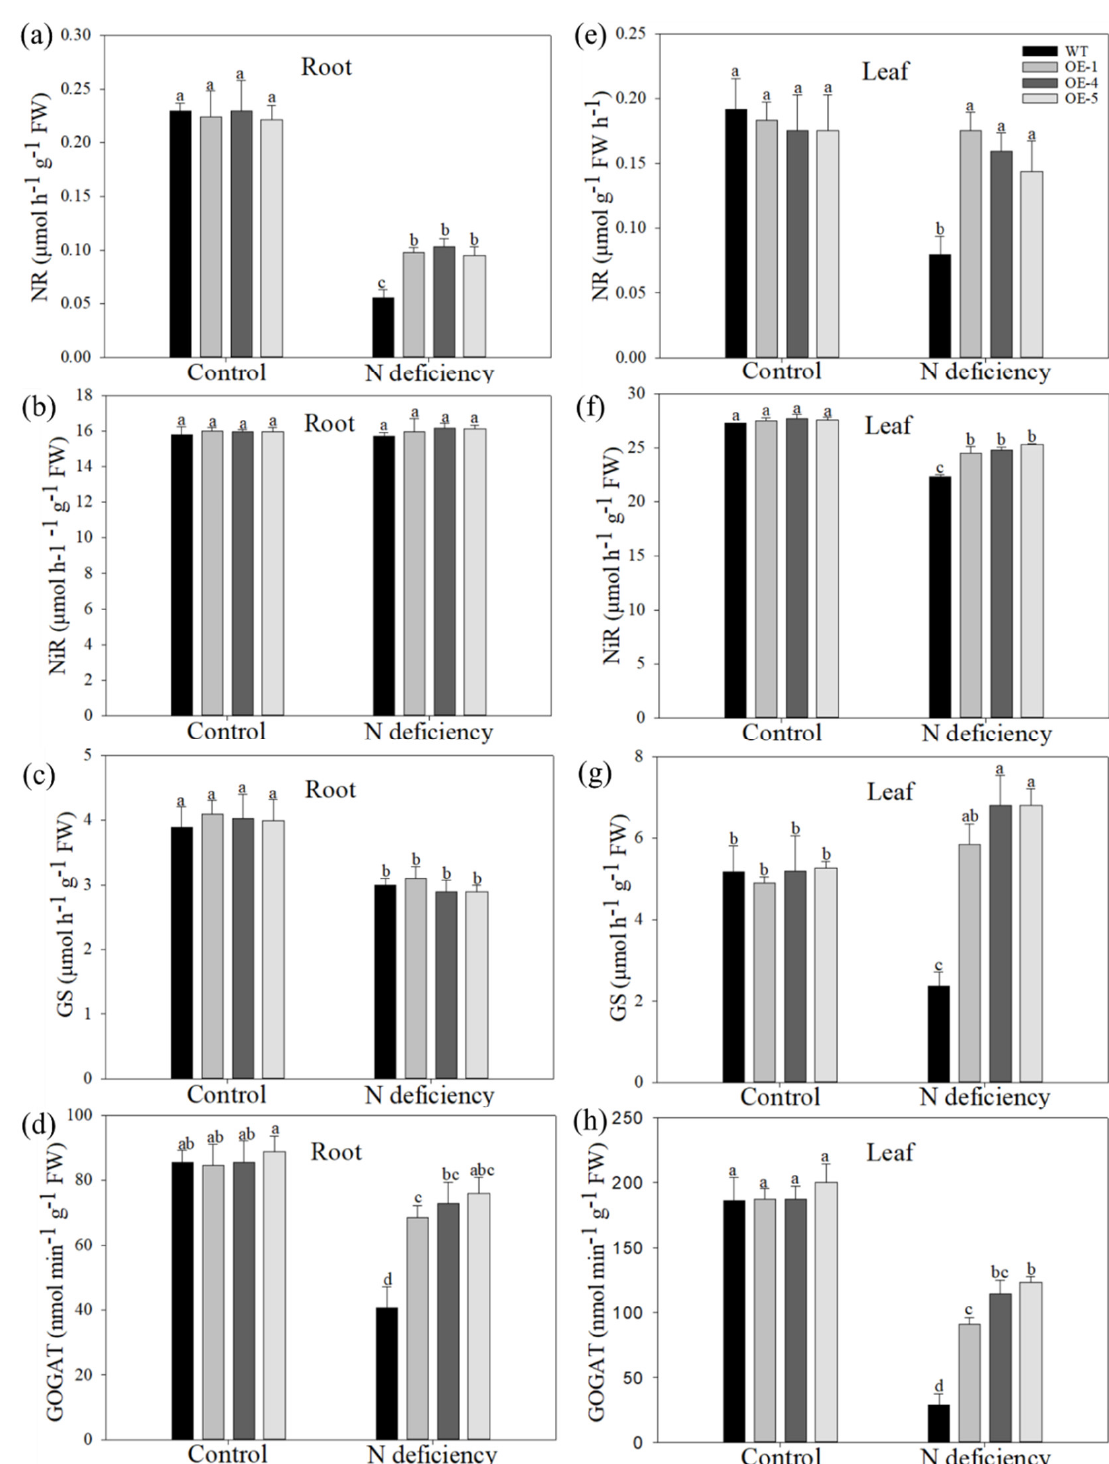
Figure 6. Overexpression of MdATG10 leads to enhanced nitrogen assimilation ability in apple under nitrogen deficiency stress. Activities of ( a ) nitrate reductase (NR), ( b ) nitrite reductase (NiR), ( c ) glutamine synthetase (GS), and ( d ) glutamic acid synthase (GOGAT) in the root ( a – d ) and leaf ( e – h ) of WT and transgenic plants with or without treatment. Data are shown as the means of three replicates with SEs. Different letters indicate significant differences between treatments, according to one-way ANOVA followed by Tukey’s multiple range test ( p < 0.05).